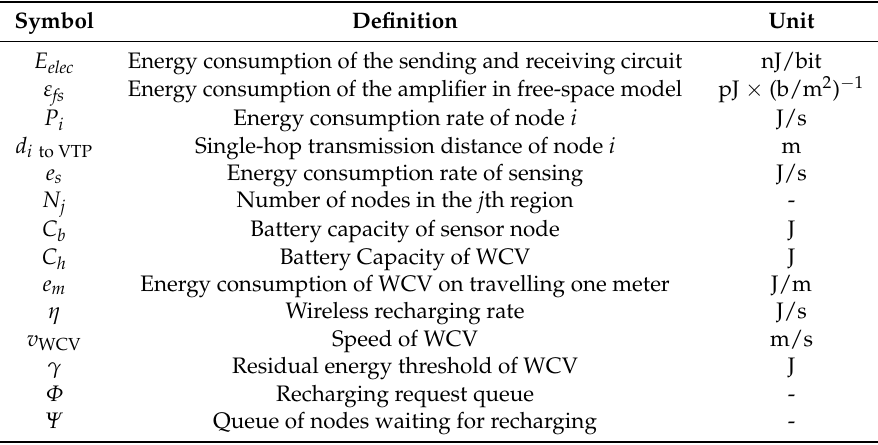
Table 3. Definitions of parameters about the adaptive recharging